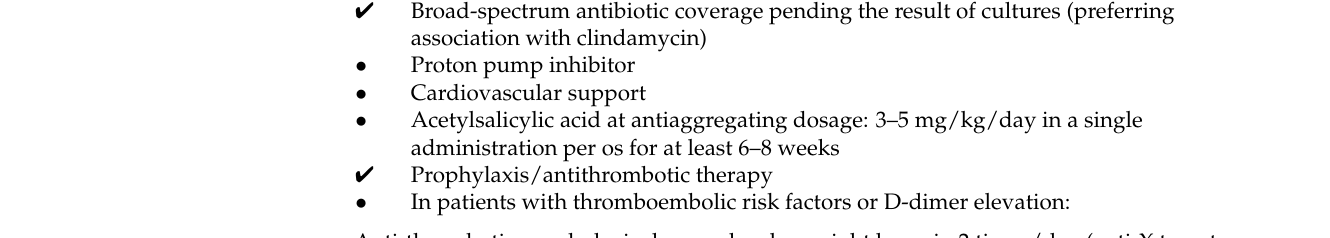
Table 6. Complementary therapies in multisystemic inflammatory syndrome (MIS-C).